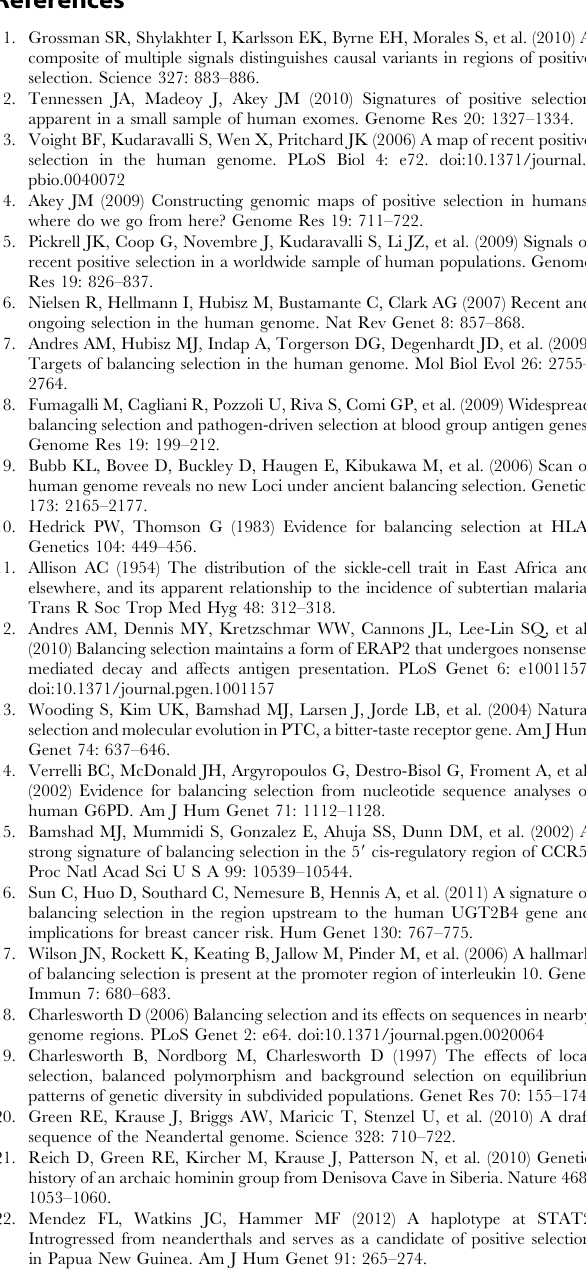
Table S5 The number of segregating sites calculated for the HKA test. Table S6 Hg18 coordinates of regions that show similar nucleotide diversity, population differentiation and site frequency spectrum. Two regions in the first 2 rows from chromosome 11 are adjacent to each other, denoting a single, larger locus with those properties. Table S7 Primers used in this study. Table S8 cis association for CEU and CHBJPT